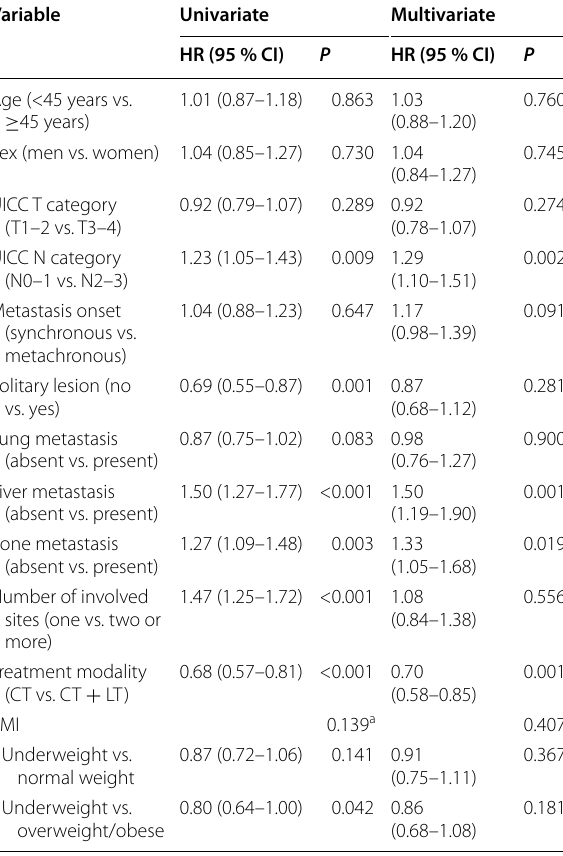
Table 3 Univariate and multivariate analyses of covari- ates associated with progression-free survival in patients with metastatic